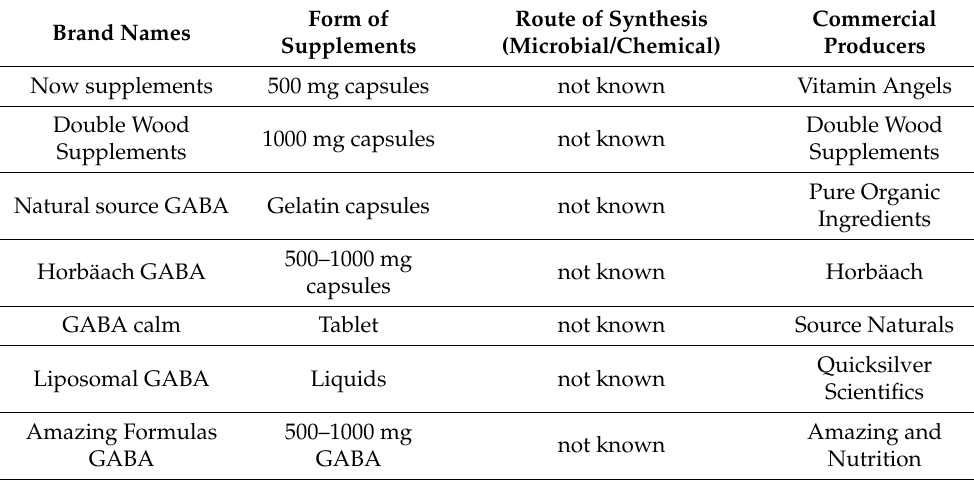
Table 1. Commercial GABA Products Available in Market **